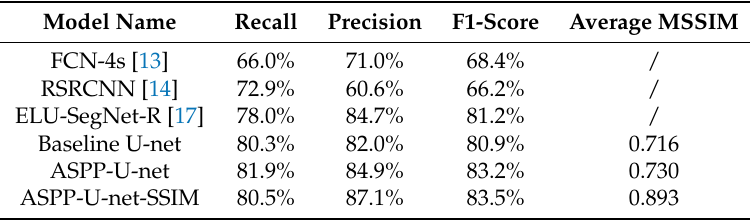
Table 2. The quantitative results of the comparative models: The performance results of the first three models listed are from several similar works that are cited in this paper, and the results of the last three models listed are from the experiments conducted in this